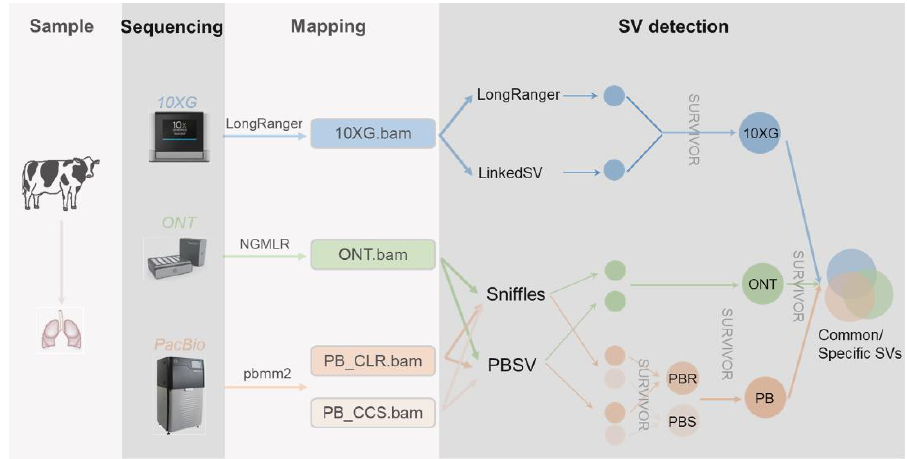
Figure 1. Sample collecting, sequencing, and mapping